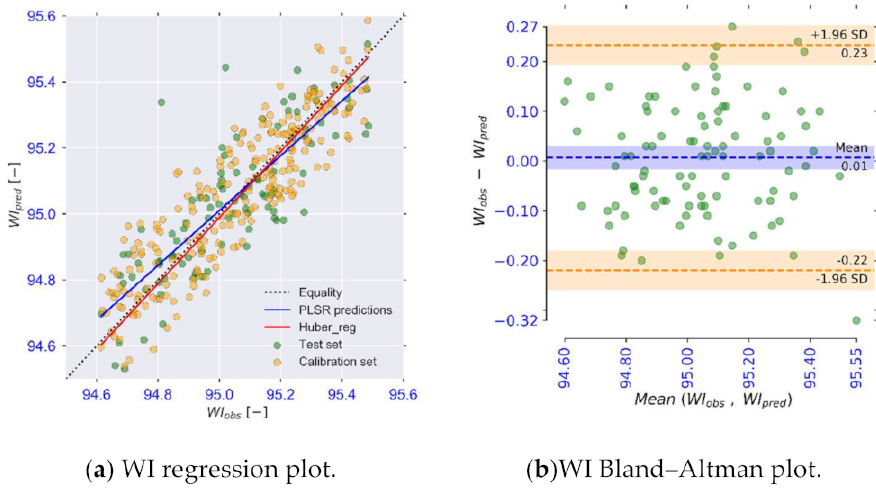
Figure 10. Regression plot and Bland-Altman plot for